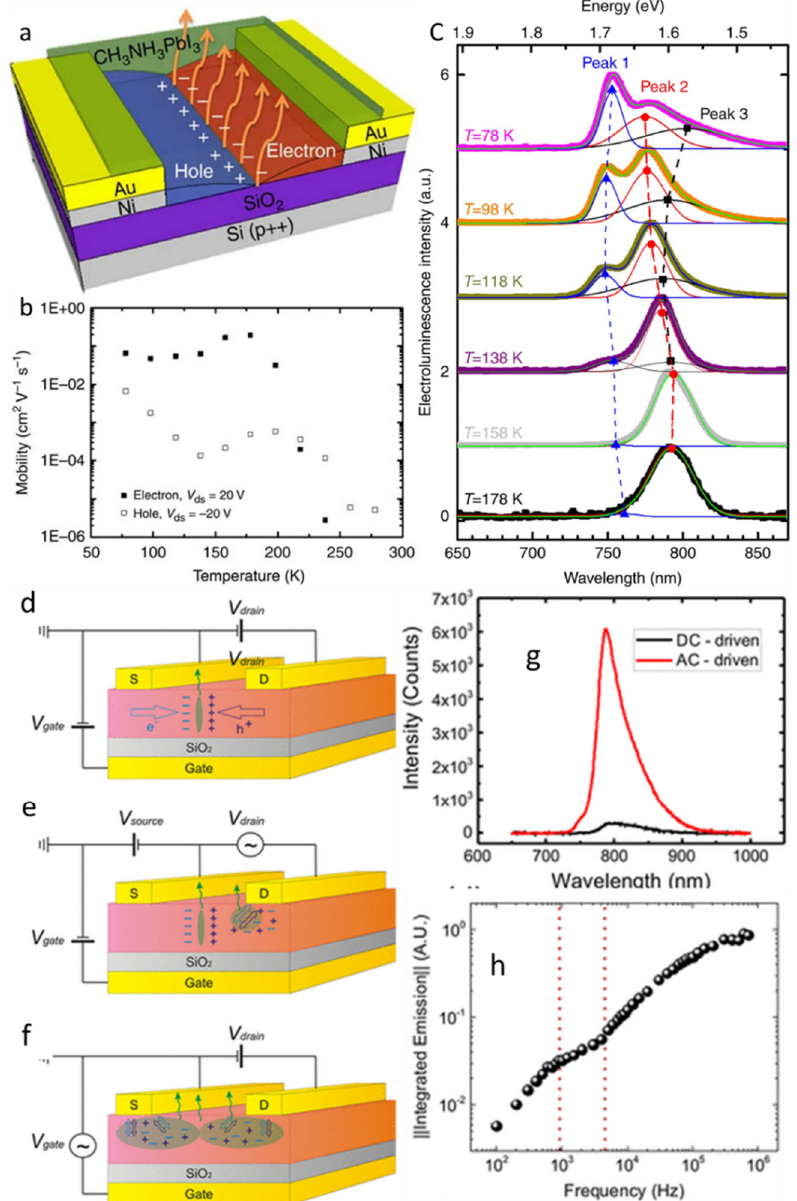
Figure 11. ( a ) The schematic of the bottom gate bottom contact light emitting FET with CH 3 NH 3 PbI 3 thin-film channel. ( b ) Variation in hole and electron mobilities of the same FETs under different operating temperatures and ( c ) electroluminescence spectra of LEFET under different operating temperatures [20]. Copyright 2015, Springer Nature. The schematics of ( d ) DC-driven gate and drain fields form a thin recombining region. ( e ) AC-driven drain field continuously injects the holes and electrons from the drain; ( f ) both electrons and holes are injected from the source and drain by the applied AC-driven gate voltage used for testing LEFETs. Reproduced with permission from [102]. Copyright 2018 Chemical American Society. ( g ) The variation in electroluminescence under fixed and pulsed gate bias and integrated emission with the frequency of the voltage pulse applied at gate. ( h ) Normalized integrated emission of the electroluminescence peaks versus driving voltage frequency. Reproduced with permission from [179]. Copyright 2017 WILEY-VCH Verlag GmbH & Co. KGaA, Weinheim.